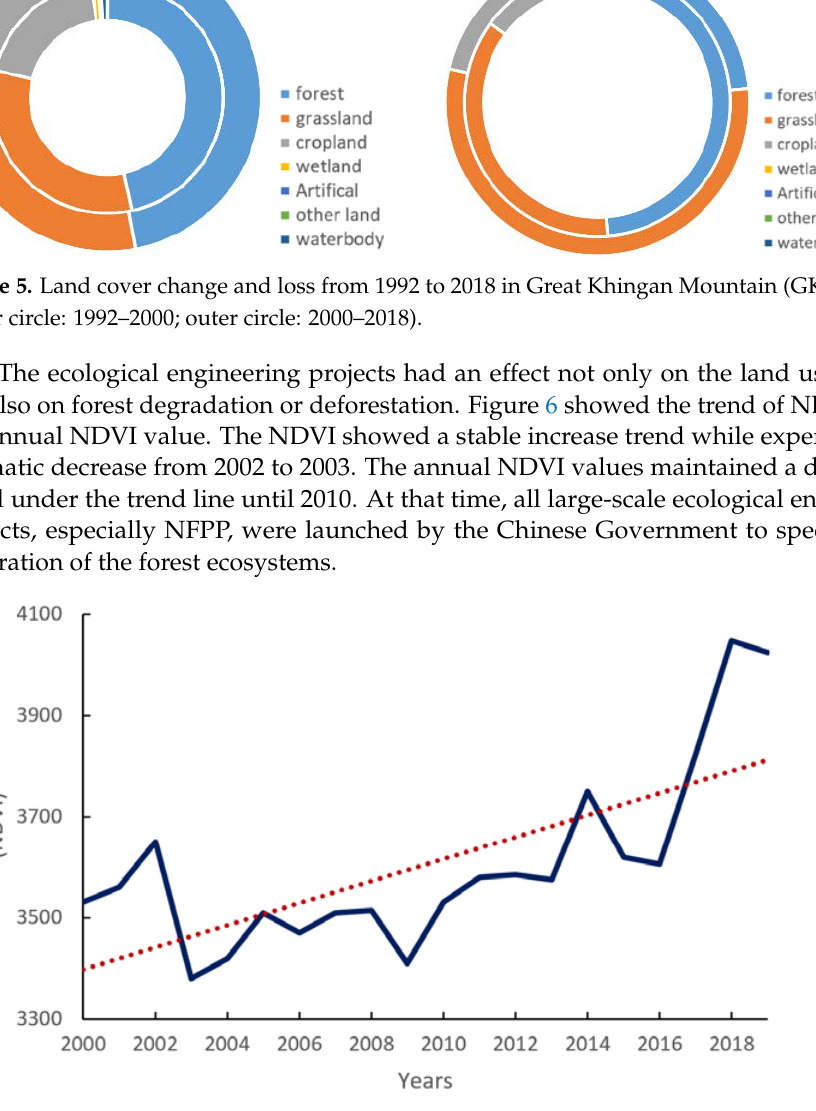
Figure 4. Land cover change and degradation in Great Khingan Mountain (GKM), China (2000–2018).